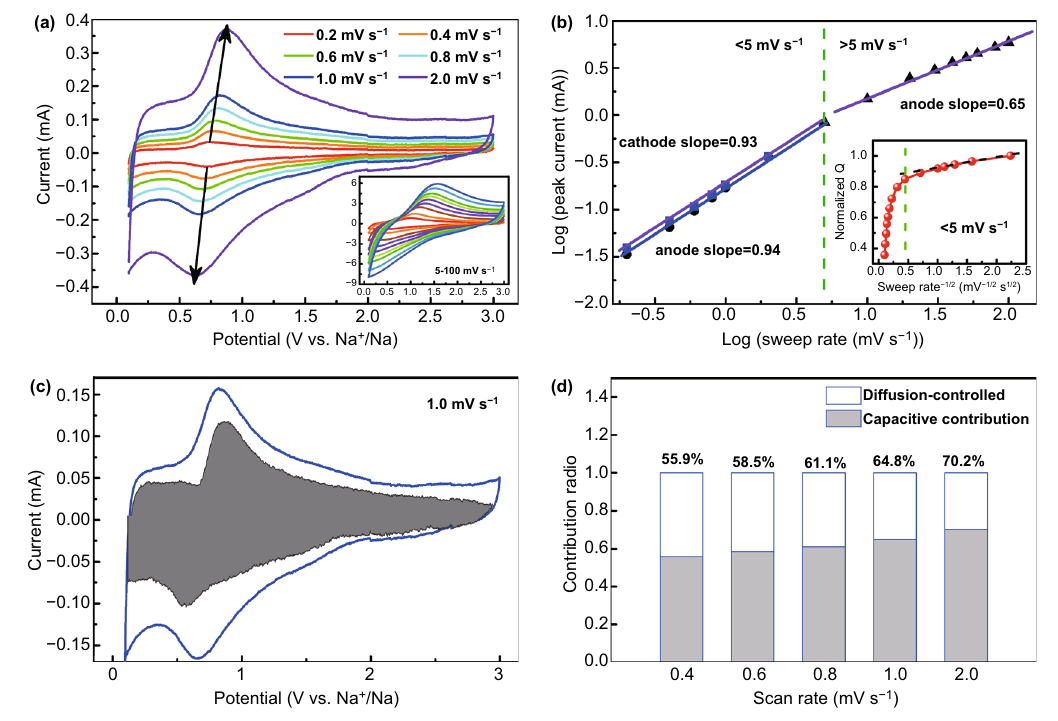
Fig. 5 Kinetics analysis of sodium ion storage behavior in the M‑TiO 2 @rGO electrode. a CV curves at different scan rates, inset: from 5 to 100 mV s −1 ; b b ‑value analysis through the relation of the peak current ( i ) and the scan rate ( v ); inset: normalized charge versus scan rate −1/2 ; c capacitive contribution area (gray) at the 1.0 mV s −1 ; and d capacitive contribution ratios at 0.4–2 mV s